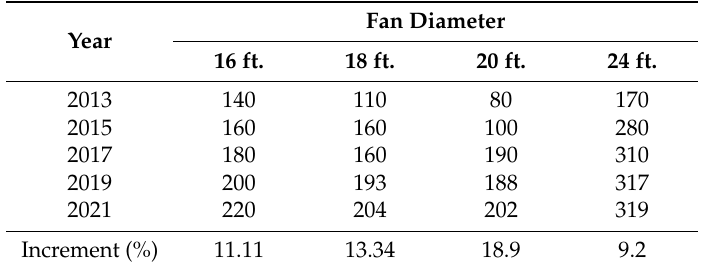
Table 3. Increment percentage of monstrous fan according to fan diameter.